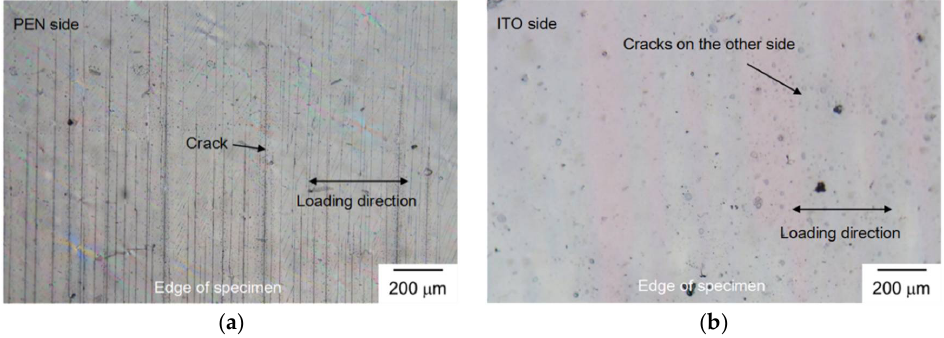
Figure 5. OM micrographs of ITO/PEN sheet after compressive bending with a 10 mm curvature radius for 1000 h: ( a ) viewed from PEN side; ( b ) viewed from ITO side.